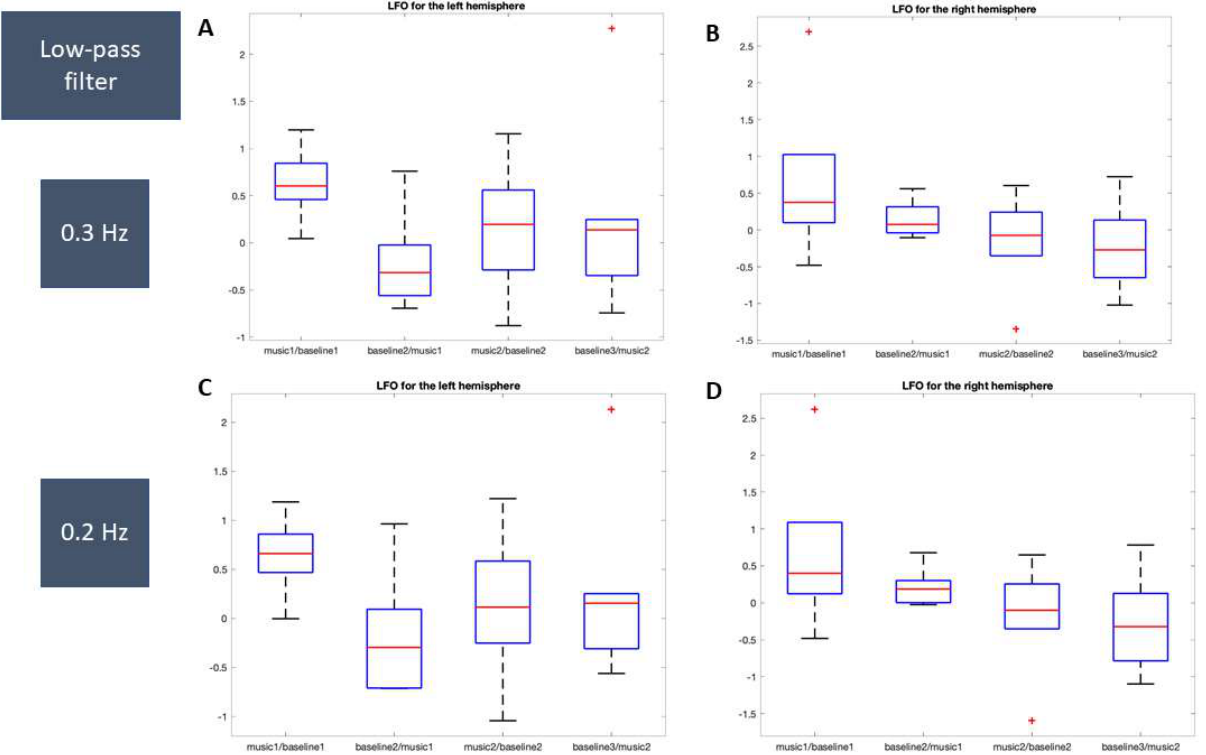
16 of 19 significant decrease is shown in b2/m1. ( B ) Ratios of LFO power in the right hemisphere. ( C ) Ratios of VLFO power in the left hemisphere. ( D ) Ratios of VLFO power in the right hemi- sphere. Figure A3. Boxplot showing, on the y -axis, the ratio of LFO power (low-frequency oscillation) and VLFO power (very-low-frequency oscillation) for O2HB calculated using an alternative cut-off of 0.03 Hz between LFO and VLFO; the same pattern of variations already observed with the cut-off of 0.04 Hz can be observed with this alternative cut-off. On the x -axis, the subsequent experimental blocks are shown: (m1/b1) from the first baseline to the first music period; (b2/m1) from the first music period to the second baseline; (b2/m2) from the second baseline to the second music block;